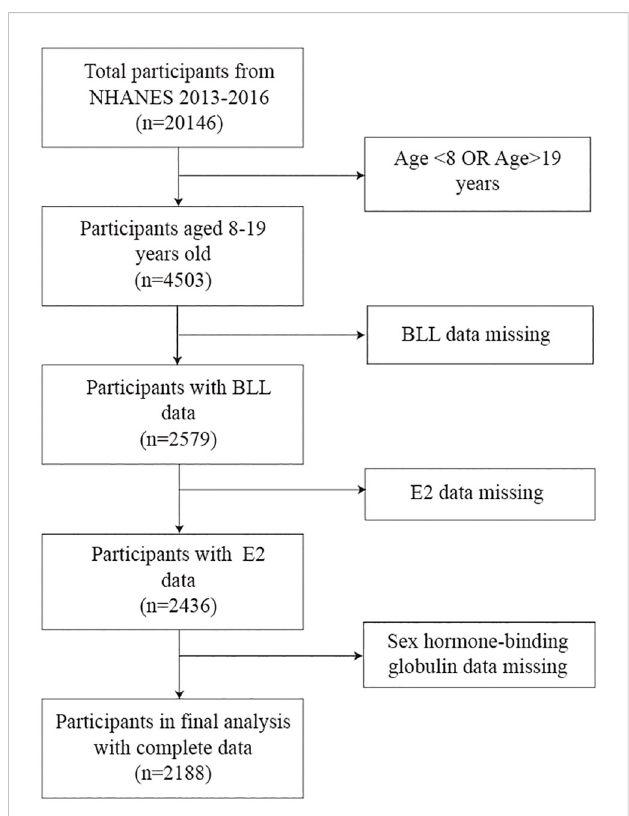
FIGURE 1 Flow diagram illustrating the process of participant selection. BLL, Blood lead levels; E2, Estradiol; SHBG, Sex hormone-binding